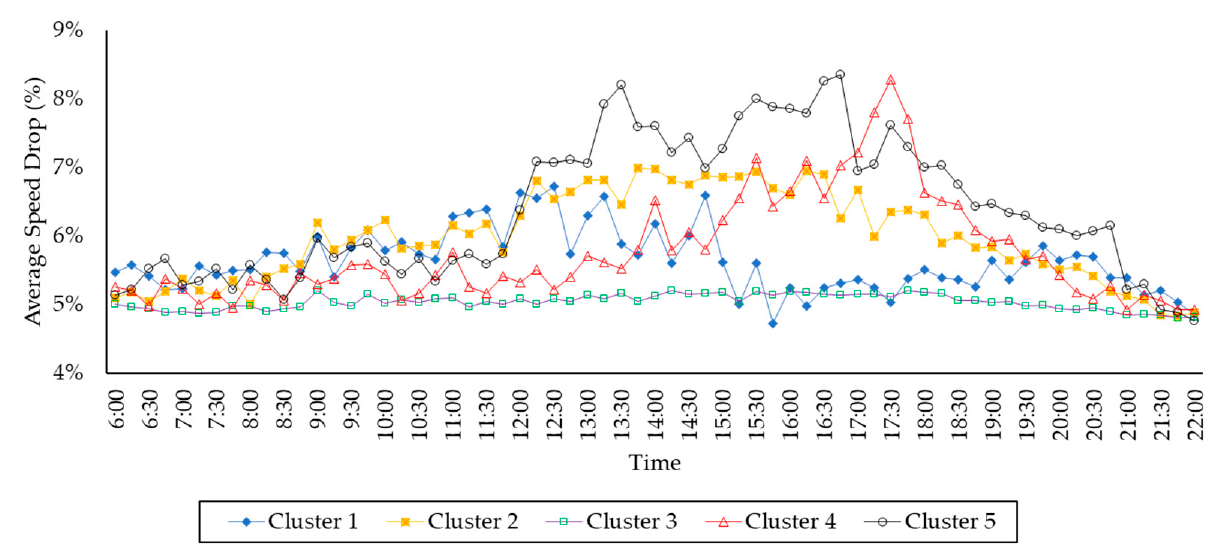
Figure 8. T he average speed drop of five clusters. Figure 8. The average speed drop of five